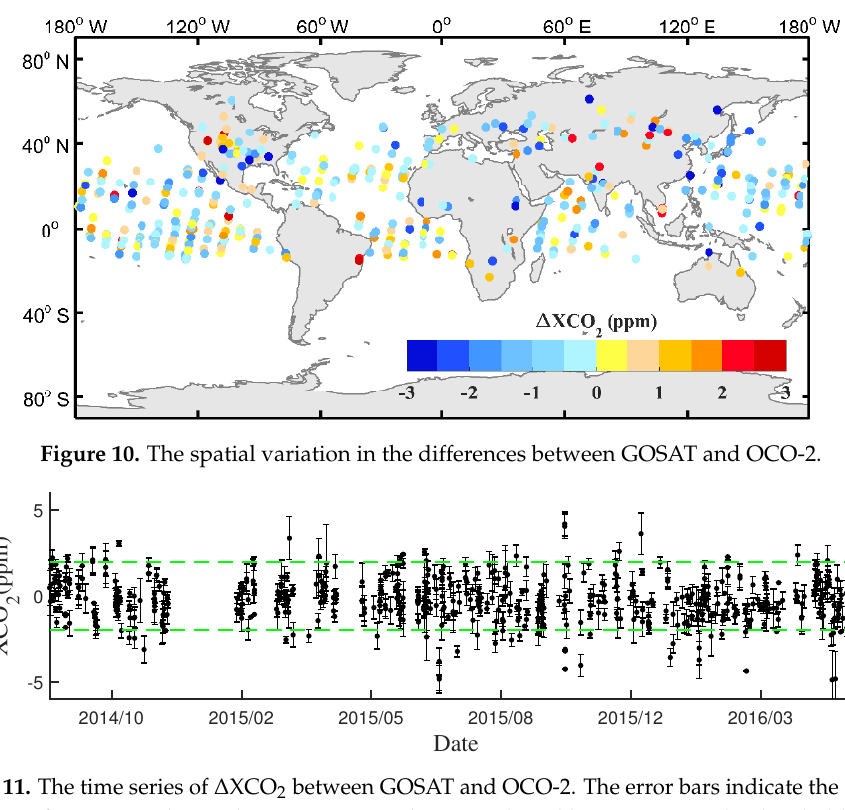
Figure 9. Scatter plot of the collocations between the GOSAT and OCO-2 XCO 2 . Scatter density: the number of collocations in each bin of 20 × 20 bins.